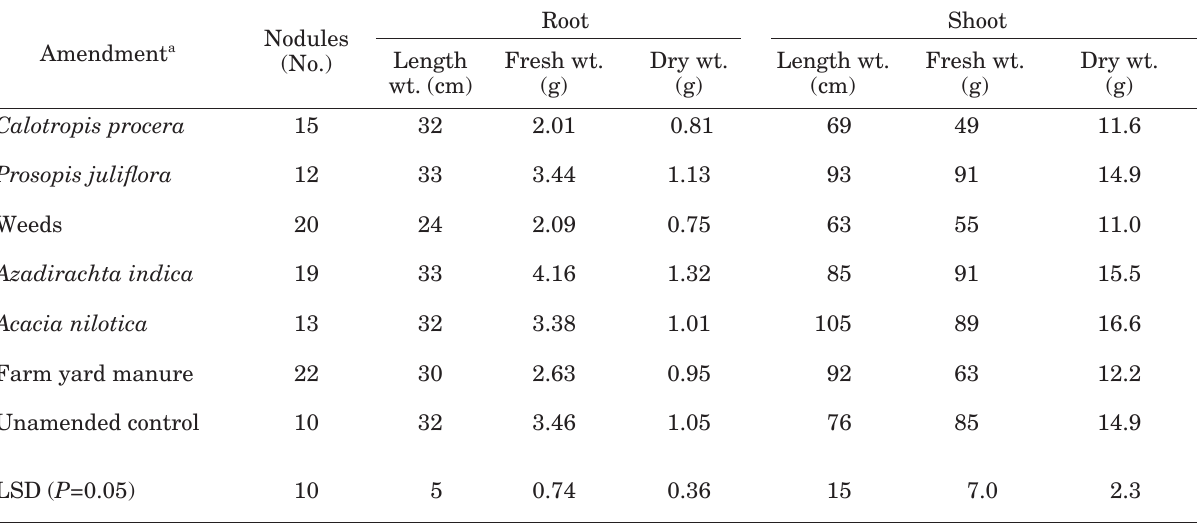
Table 3. Effect of compost-amendments on some growth parameters of cowpea (2001). Nodules (No.)